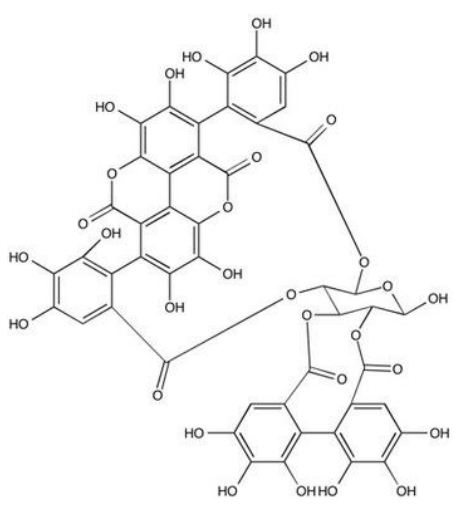
Figure 1. The chemical structure of punicalagin.